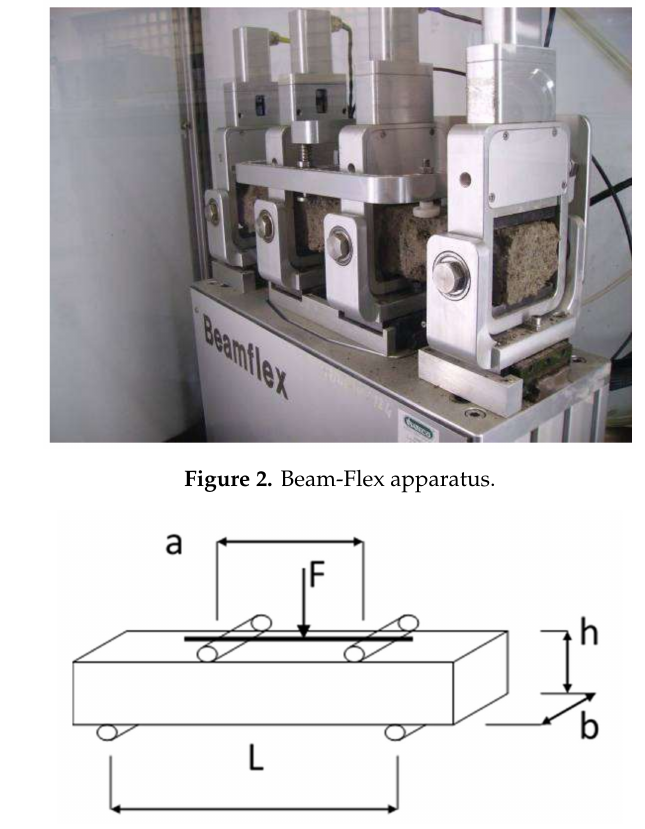
Figure 3. Load diagram for FAC mixture samples in the 4PB